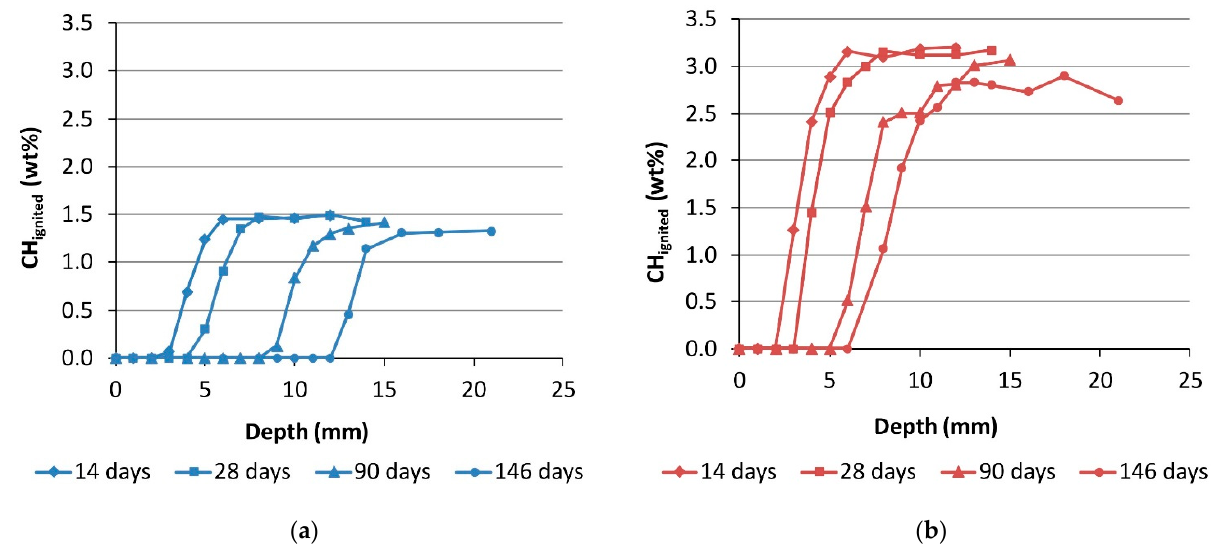
Figure 5. CH content measured with thermogravimetric analysis (TGA) after 14, 28, 90 and 146 days of exposure to accelerated carbonation for ( a ) EnDurCrete mortar (EnM-06); and ( b ) the reference mortar (RefM-06), Both made with a w/c ratio of 0.6.